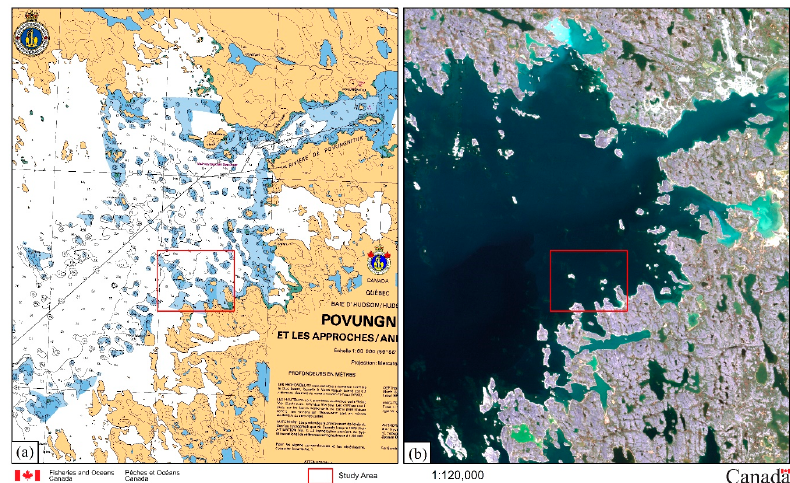
Figure 4. Location of Study Site 2, near Taloyoak, Nunavut.